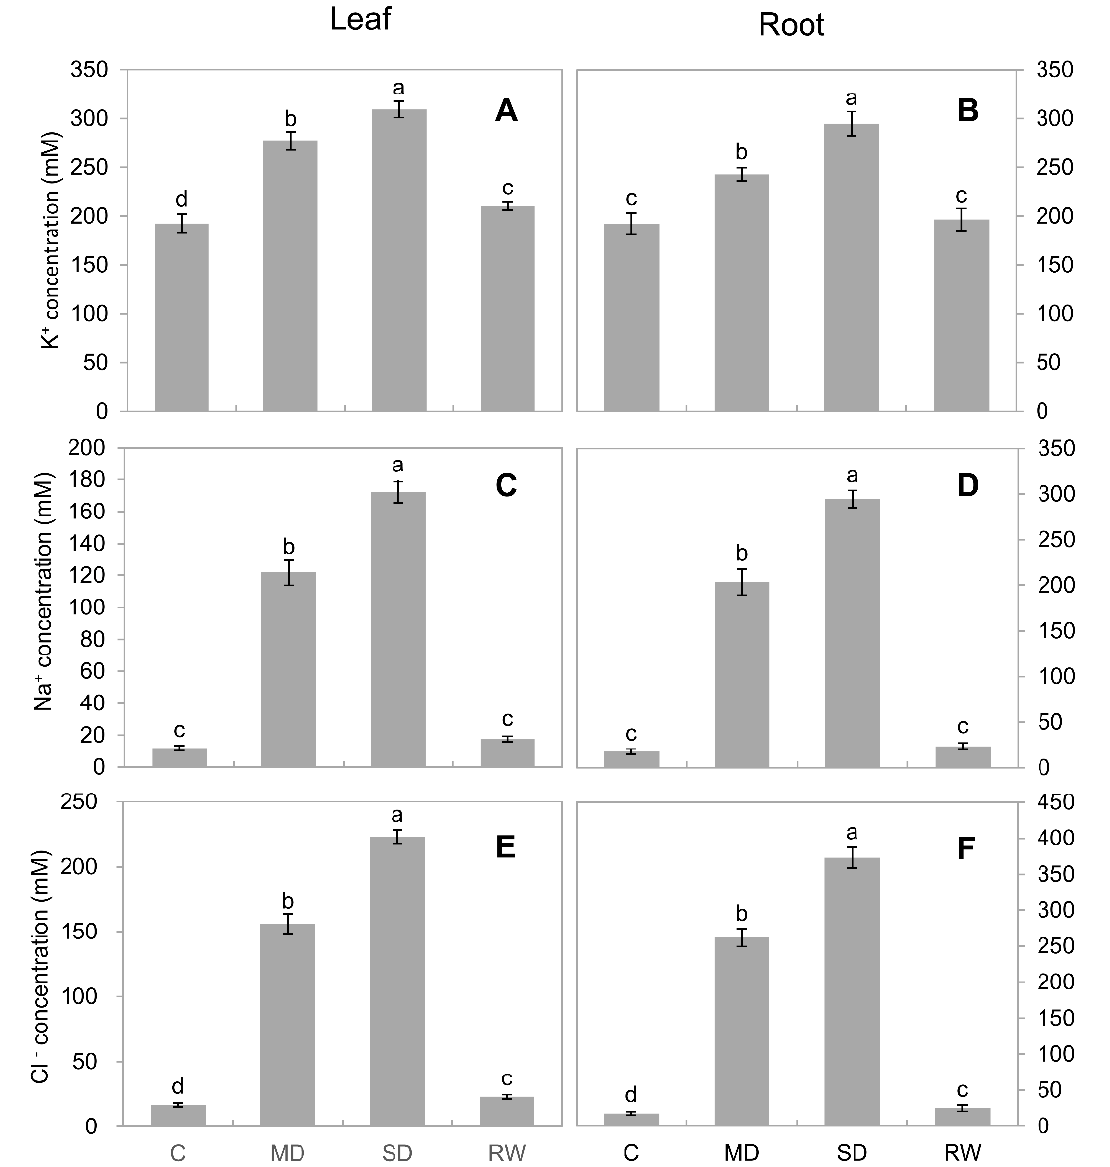
Figure 7. The accumulation of inorganic ions in the leaves and roots of C. duriuscula under drought stress. C-control, MD-mild stress, SD-severe stress, RW-re-watering. ( A , B ) K + concentration, ( C , D ) Na + concentration, ( E , F ) Cl − concentration. Data are means ± SE ( n = 3–6). Data labeled with different lower-case letters are significantly different at p < 0.05.